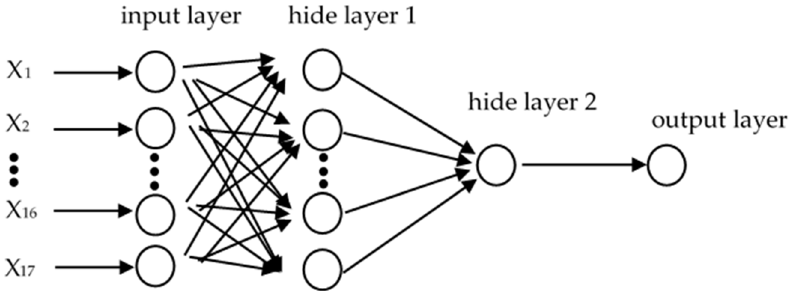
Figure 1. Structure diagram of back propagation (BP) neural network model.